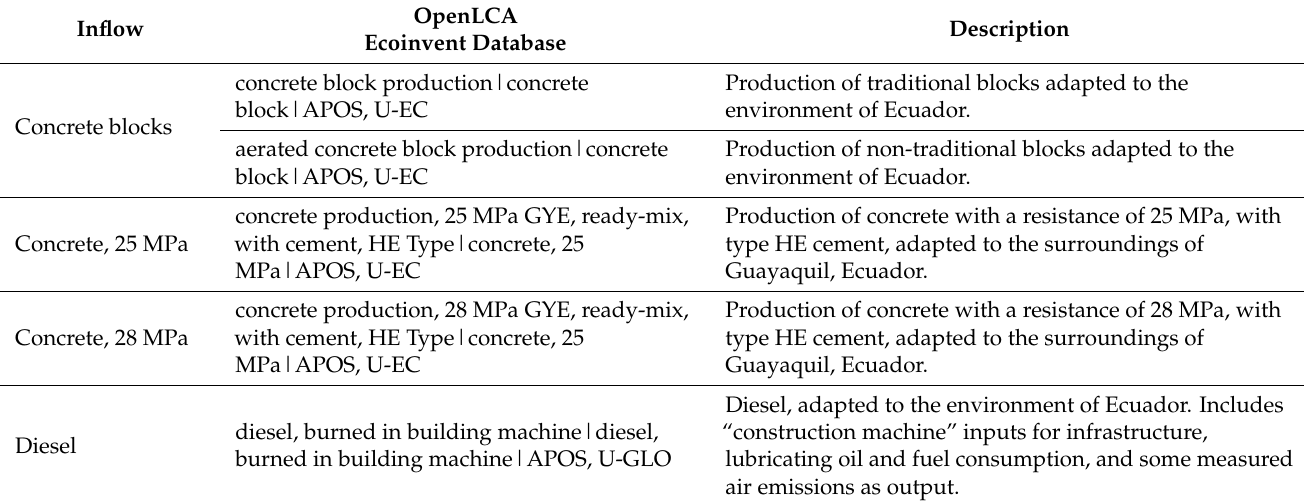
Table 4. Summary of processes taken from the Ecoinvent database for the construction of a house (traditional and new